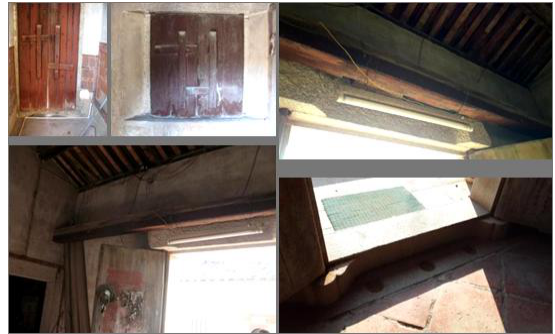
Figure 13. Historic residence‘s security doors and